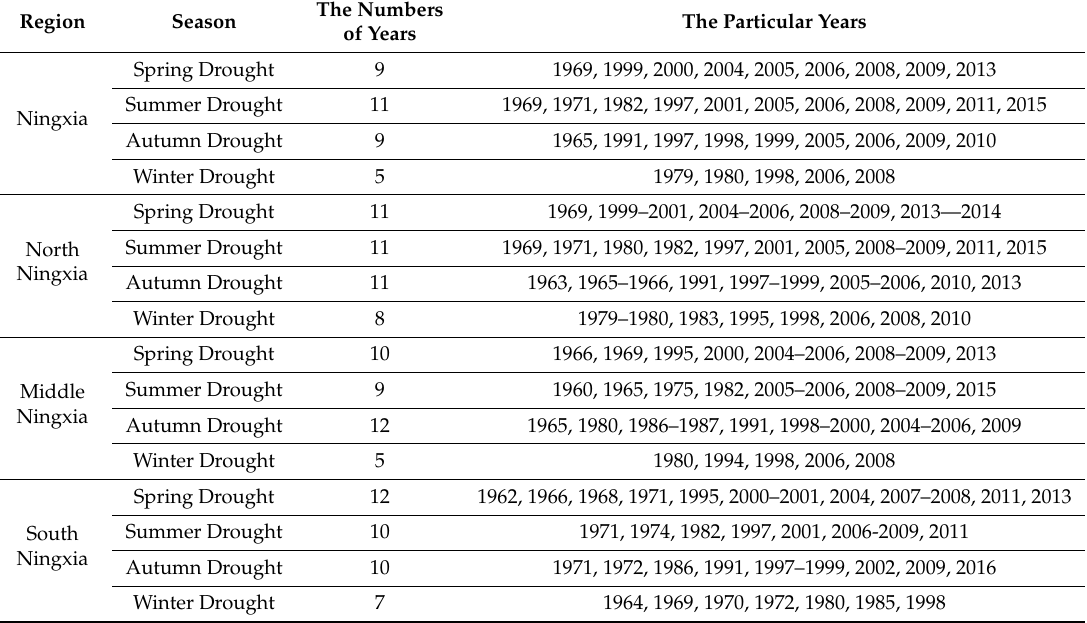
Table 2. The numbers of years and the particular years of the full-scale drought occurs in the whole and three sub-regions of each